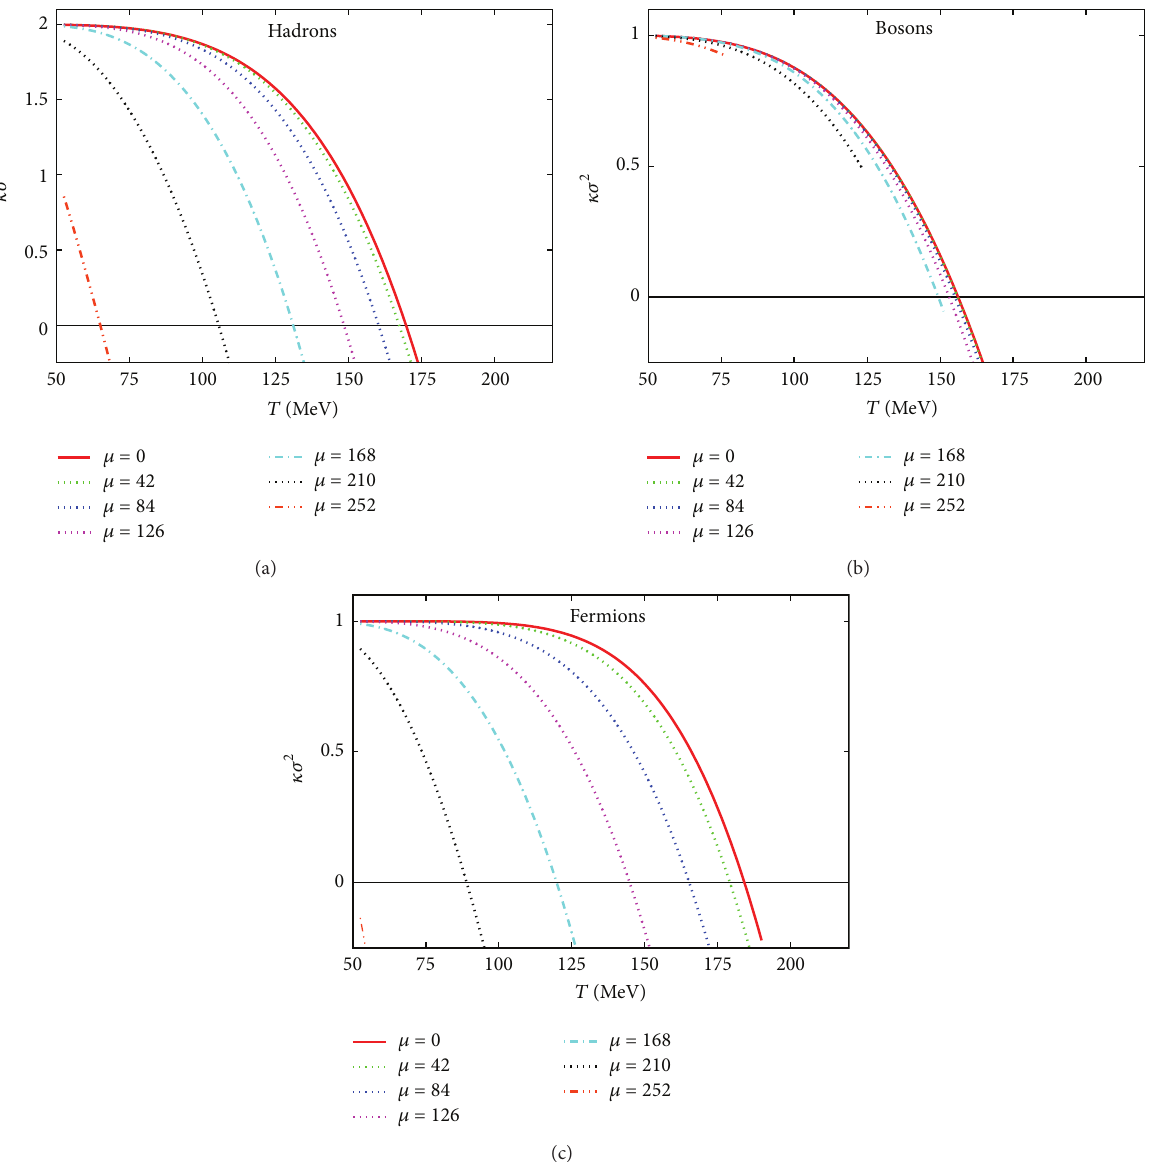
Figure 7: The product 𝜅𝜎 2 is given as a function of 𝑇 at various 𝜇 -values for hadronic (a), bosonic (b), and fermionic (c) resonance